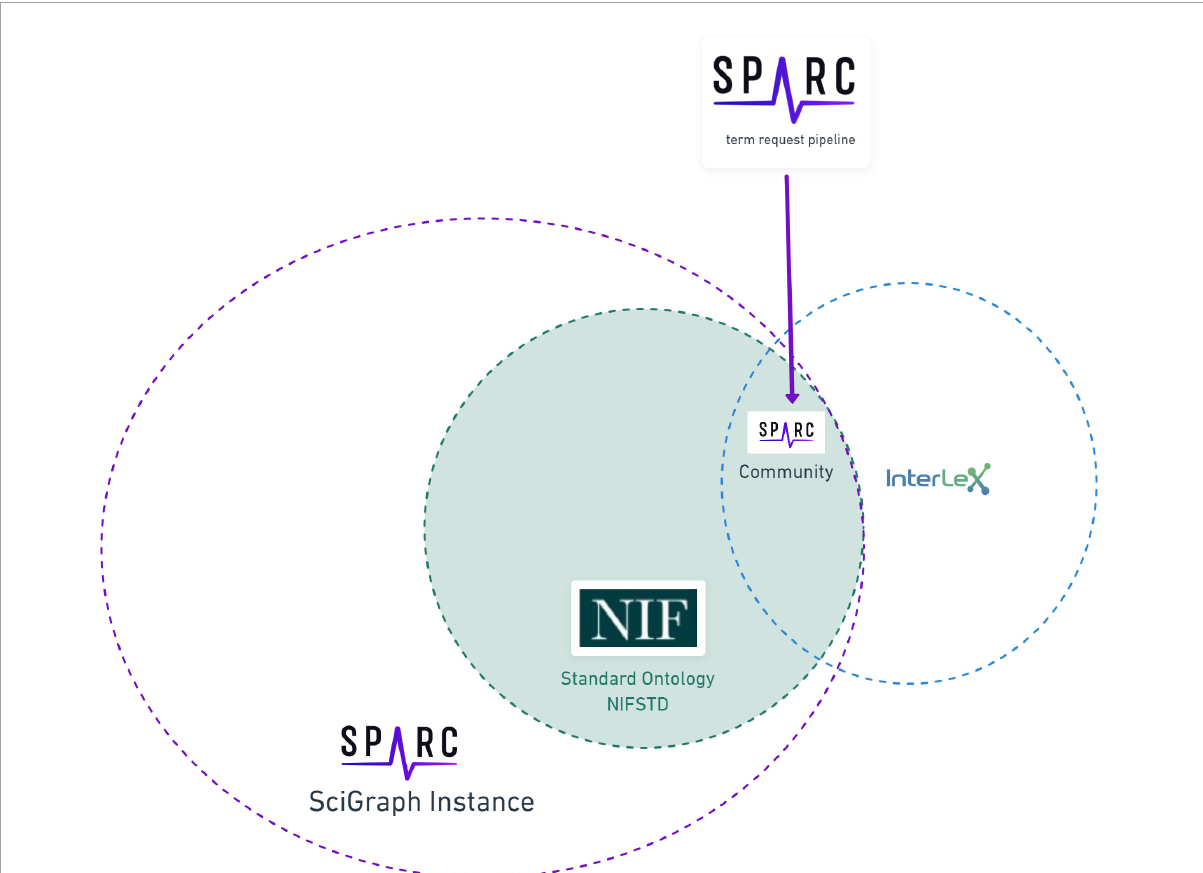
FIGURE2 The relationship of the SPARC vocabulary to infrastructure components. The SPARC Vocabulary is represented by the large circle on the left (solid dotted line). The entire SPARC Vocabulary is available through a SciGraph instance, including the full imports of community ontologies comprising the vocabulary. The totality of InterLex is represented by the small circle on the right (blue dotted line) that partially exists within the SciGraph instance. The overlap between these circles represents the subset of the SPARC Vocabulary that is available in both InterLex and SciGraph that is made available via the SPARC Community Portal (purple dotted line) and augmented through the term request